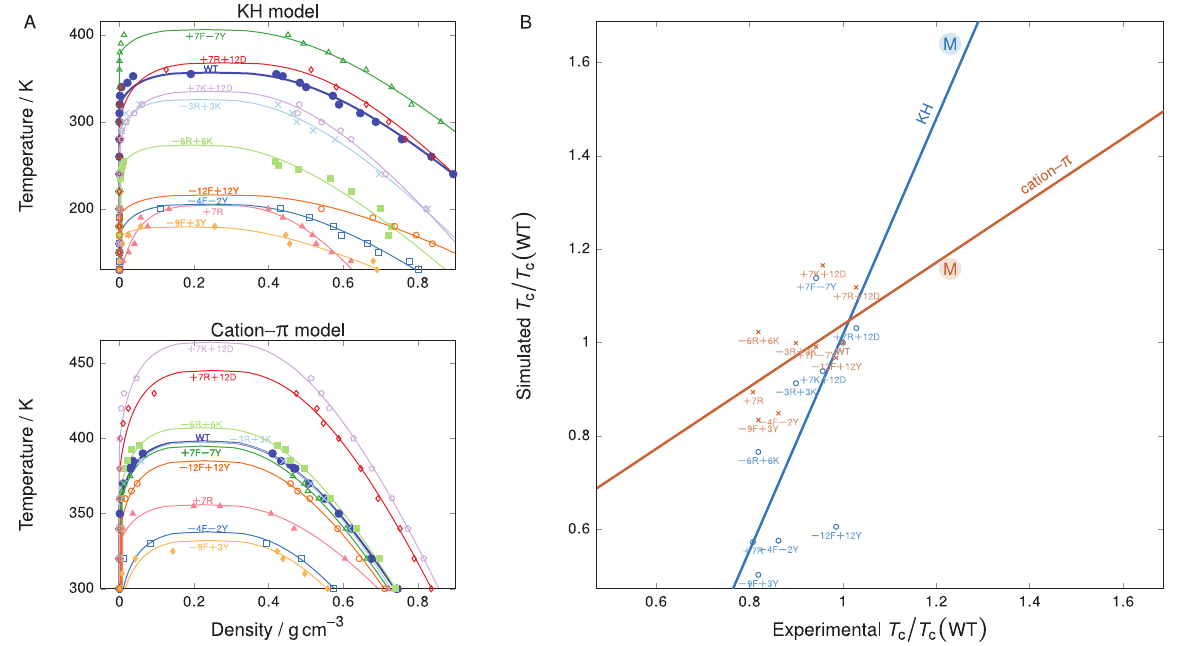
Fig 7. Comparison of model predictions with experiment. In (A) , we show phase diagrams obtained with two coarse-grained models for a variety of modifications of the hnRNPA1 sequence. Symbols correspond to simulation results. Solid lines are obtained by the fitting procedure described in S1 Text (Sec. S1-b). In (B) , we show the correlation plot between simulation and experimental data, alongside a linear fit to the data points. The adjusted squared sum of residuals is R 2 = 0.96 for the KH model and R 2 = 0.99 for the cation– π model, with p values of 0.0007 and 0.012, respectively. The Pearson correlation coefficients are 0.66 (KH) and 0.64 (cation– π ). The point labelled ‘M’, which was not included when computing the linear fit or the correlation coefficients, corresponds to the sequence with the largest critical point obtained in our genetic- algorithm run (see S1 Text (Sec. S7)); since there are no experimental data available for this specific sequence, we have estimated the experimental critical temperature using the ABSINTH model.